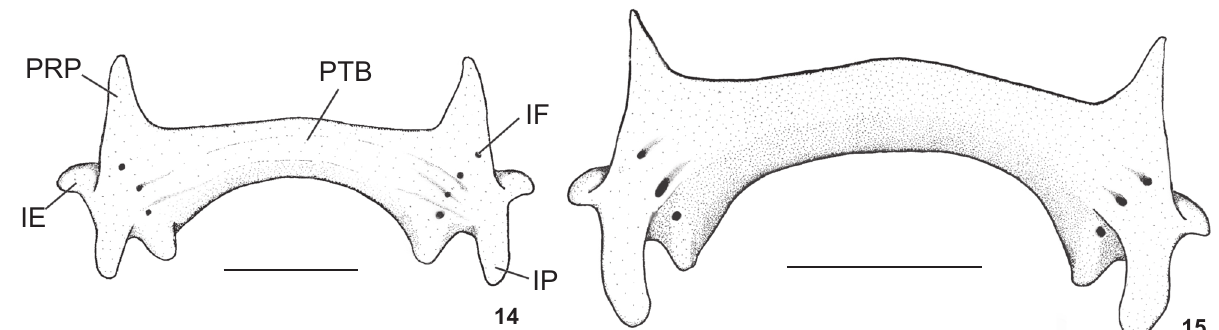
Figures 14-15. Puboischiadic bar of D. mennii : (14) dorsal view of male (UERJ 2103); (15) ventral view of female (UERJ 2105). (PRP) prepelvic processes, (PTB) transverse pelvic bar, (IE) iliac extension, (IF) iliac foramen, (IP) iliac process. Scale bars: 14 = 40 mm, 15 = 50 mm.